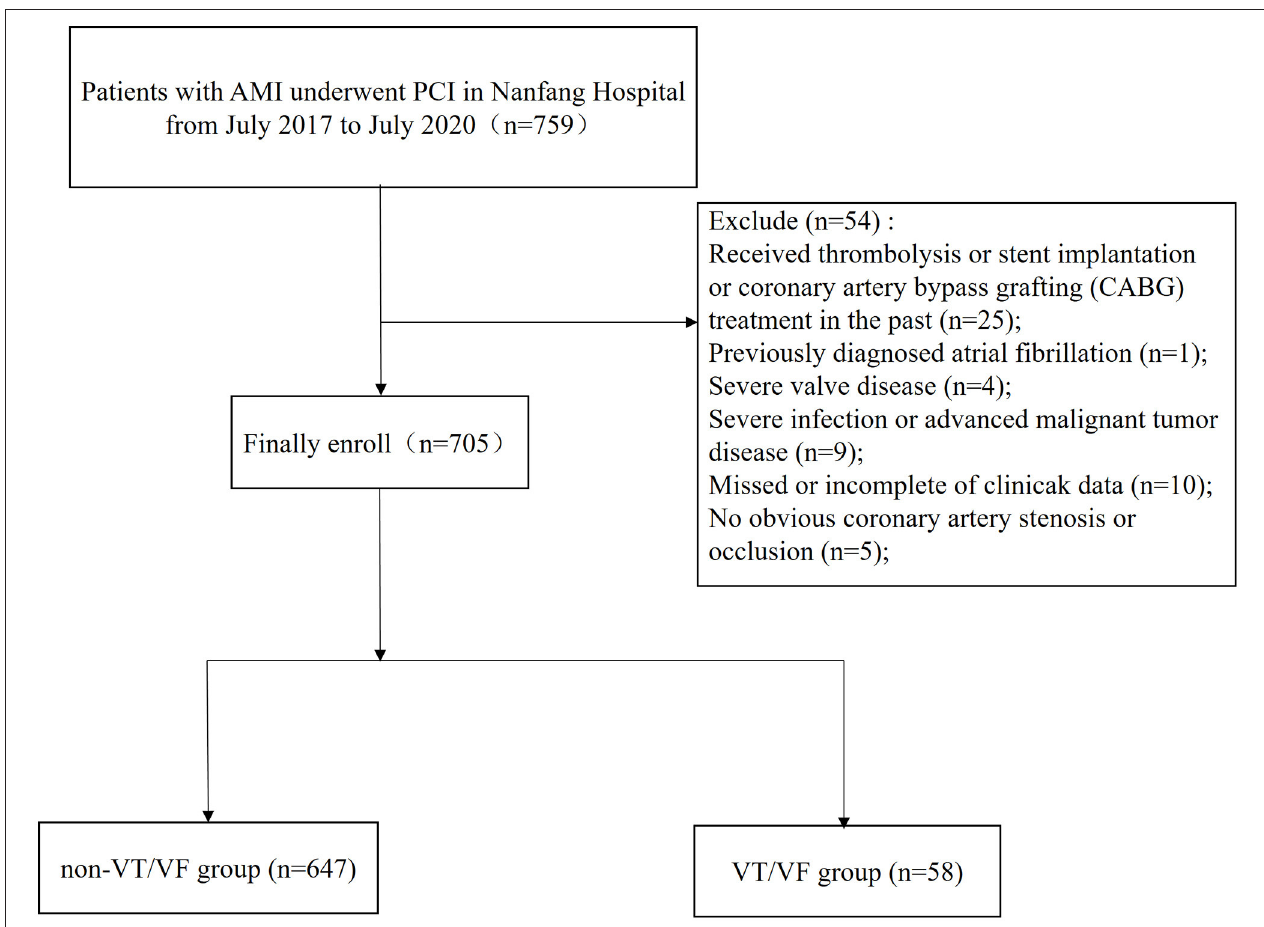
FIGURE 1 | A flow chart of study design and